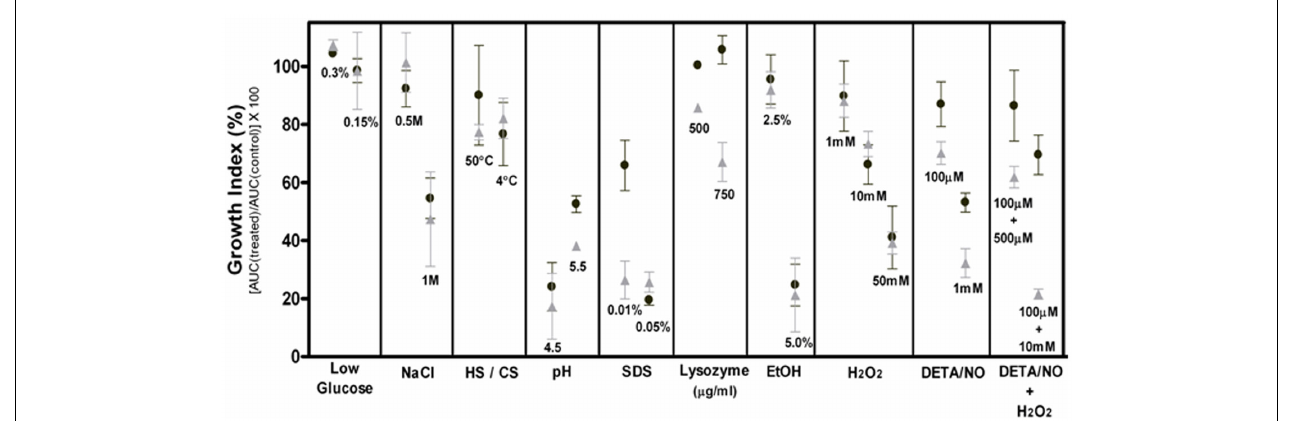
triangles) strains exposed to various stress conditions in vitro (see text for details), in comparison to non-treated controls. HS, heat shock; CS, cold